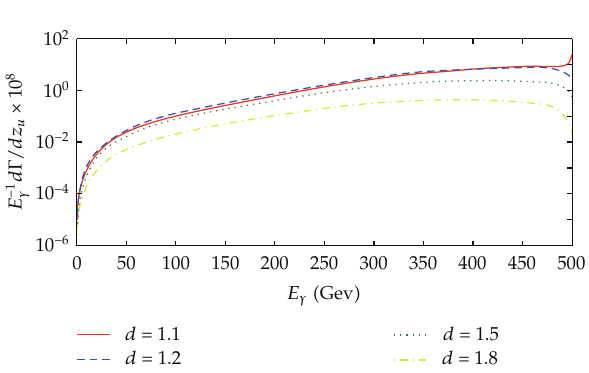
Figure 1: Energy distribution E − 1 d Γ /dz u × 10 8 for E γ (cid:10) 0–500GeV, depending on d (cid:10) 1 . 1 , 1 . 2 , 1 . 5 , 1 . 8; γ c v (cid:10) a v (cid:10) 1, Λ (cid:10) 1TeV, m Z (cid:2) (cid:10)